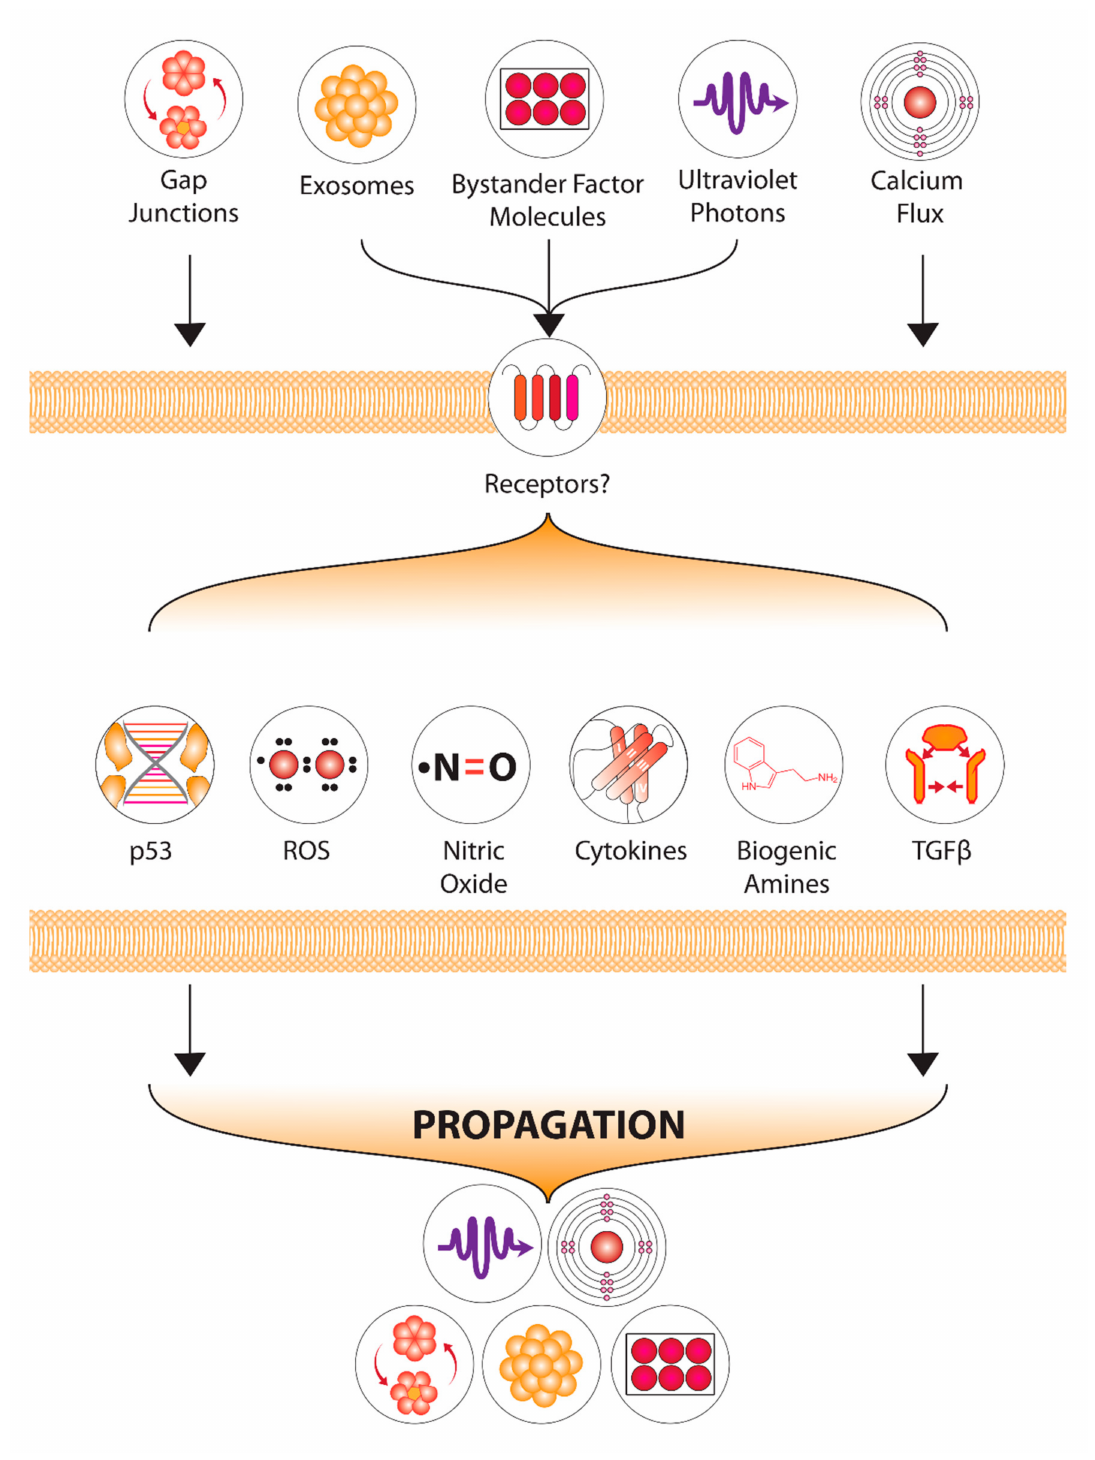
Figure 6. Current understanding of non-targeted effect mechanisms with possible intervention points to optimize hypoxic tumour cell